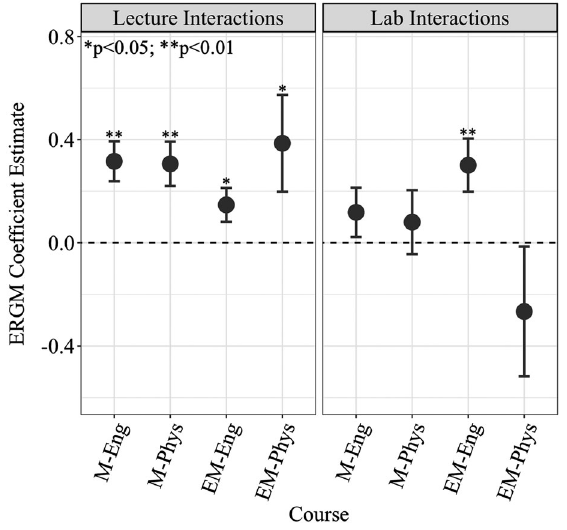
FIG. 5. Plot of ERGM coefficients for the main effect of final course grade on degree variable for each observed network. A more positive (negative) coefficient estimate indicates that students with higher final course grades have more (fewer) total connections in the network than students with lower final course grades. Error bars indicate the standard error for each estimate and asterisks indicate statistical